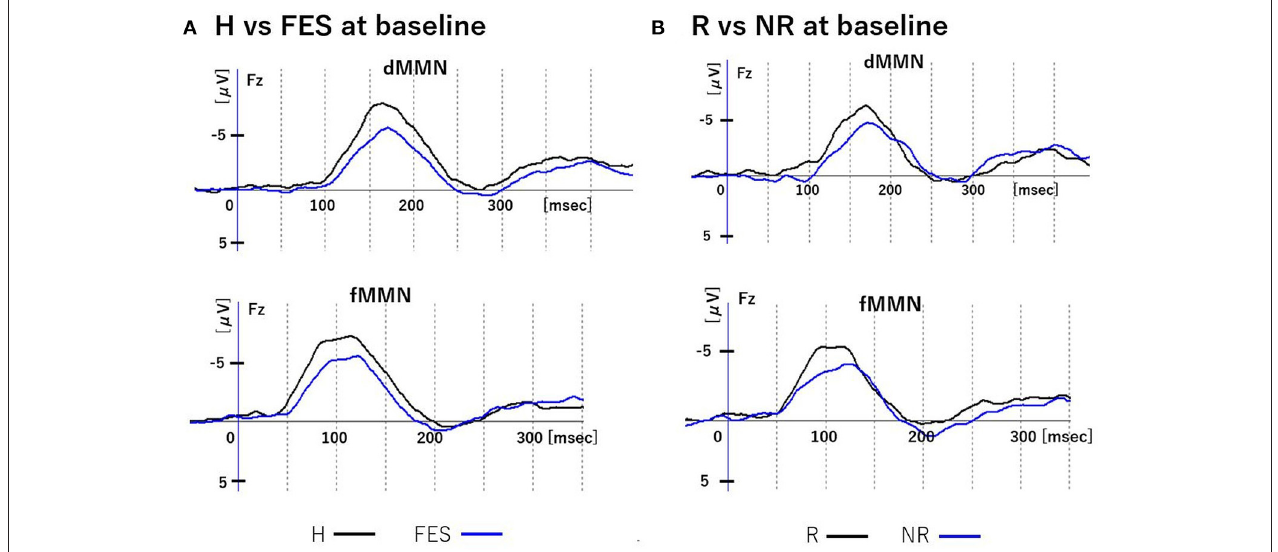
FIGURE 2 | MMN waveforms at baseline. Figure shows grand average waveforms of dMMN and fMMN at Fz. (A) shows the waveforms of the H and FES groups. (B) shows the waveforms of the R and NR groups. Abbreviations: dMMN, duration mismatch negativity; fMMN, frequency mismatch negativity; H, healthy controls; FES, first episode schizophrenia; R, schizophrenia remitter; NR, schizophrenia non-remitter.